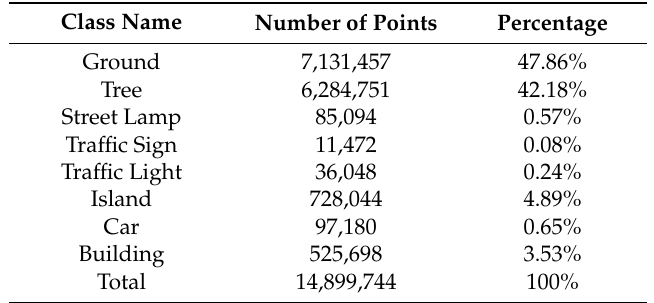
Table 6. Number of points and percentage of each class for MLS point cloud.